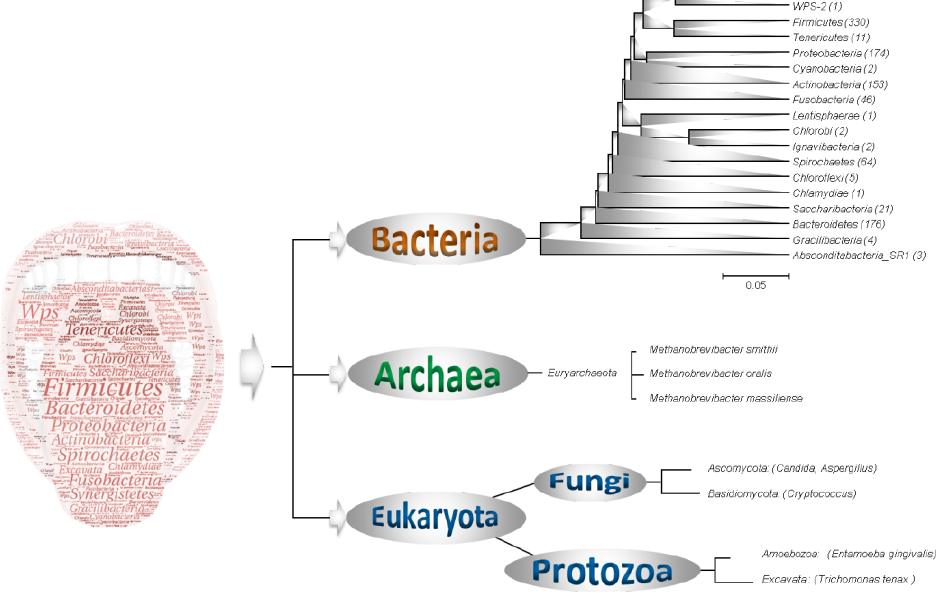
Figure 1. Phylogenetic diversity of the 19 phyla isolated or detected at least once in the human oral cavity. The number of species per phylum is presented between parents in the phylogenetic tree. The illustration on the left of the figure was made using the online tool wordle (www.wordle.net; accessed on 23 January 2023); the size of the name of each phylum is proportional to the number of species it contains. The phylogenetic tree was created using MEGA software. Figure 1 was built according to data collected from the Human Oral Microbiome Database; https://www.homd.org/; accessed on 23 January